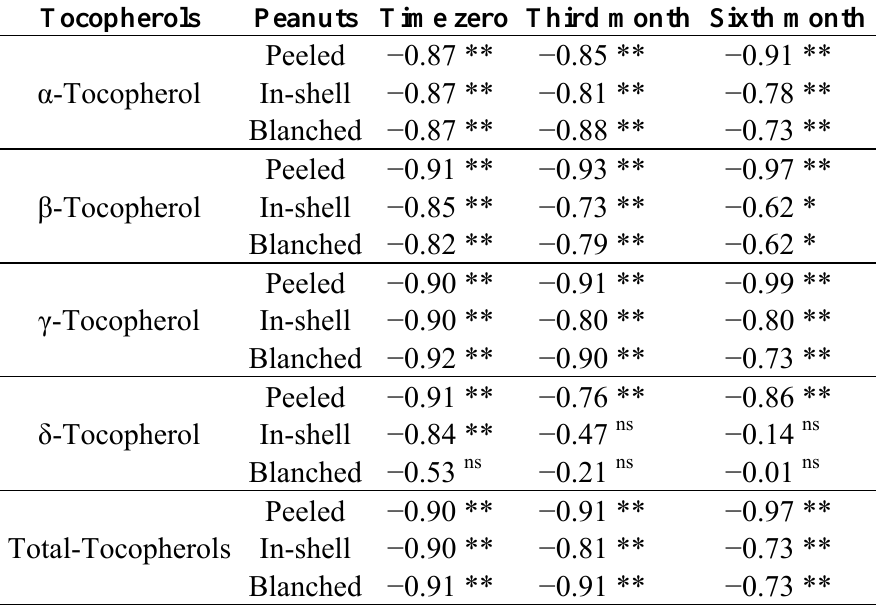
Table 4. Pearson’s correlation between gamma radiation and tocopherol